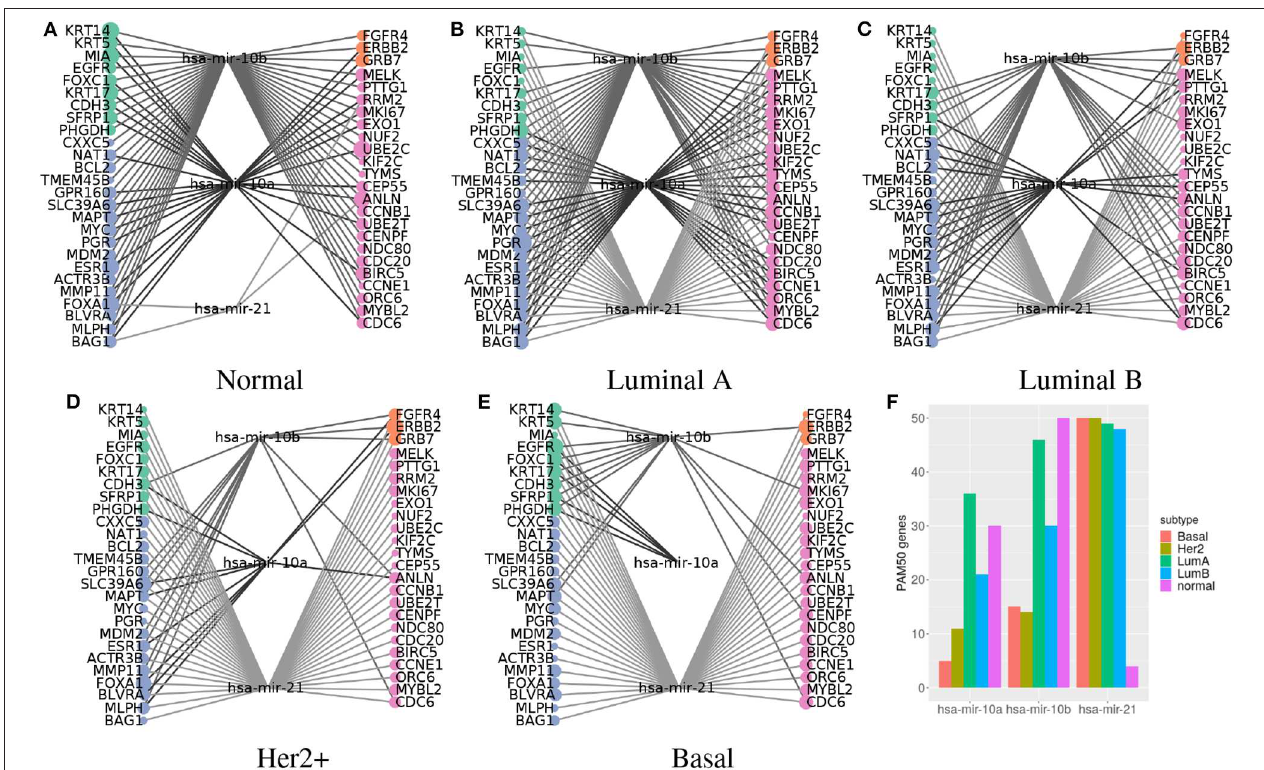
FIGURE 6 | Predictors connecting most PAM50 genes transition from miR-10a/b in normal tissue to miR-21 in cancer subtypes. (A–E) PAM50 genes are at the sides, colored according to their pattern of expression: green for basal expression, orange for Her2 enriched, blue for luminal expression, and pink for proliferation favorable. Node size represents the number of predictors selected. Predictors are in the middle. Lines connect PAM50 genes to the associated predictors. Lines are in a gray gradient to distinguish different predictors. (F) The bar chart represents the number of PAM50 genes connected to the miRNAs per